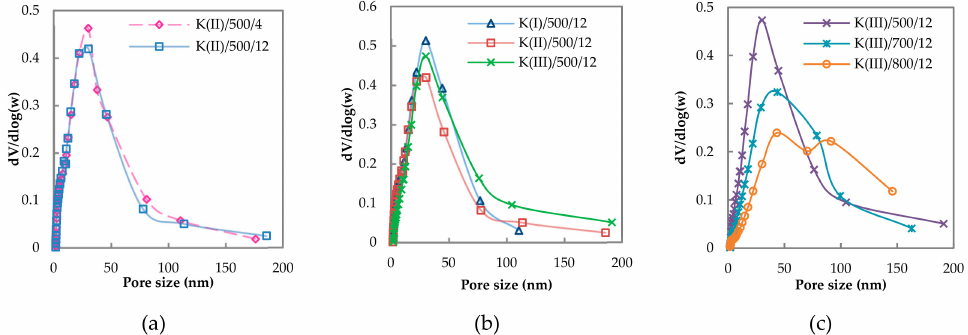
Figure 1. Pore size distribution of selected catalysts: ( a ) E ff ect of calcination time for samples K(II) / 500 / z , ( b ) e ff ect of K amount for samples K( x ) / 500 / 12 and ( c ) e ff ect of calcination temperature for samples K(III) / y /